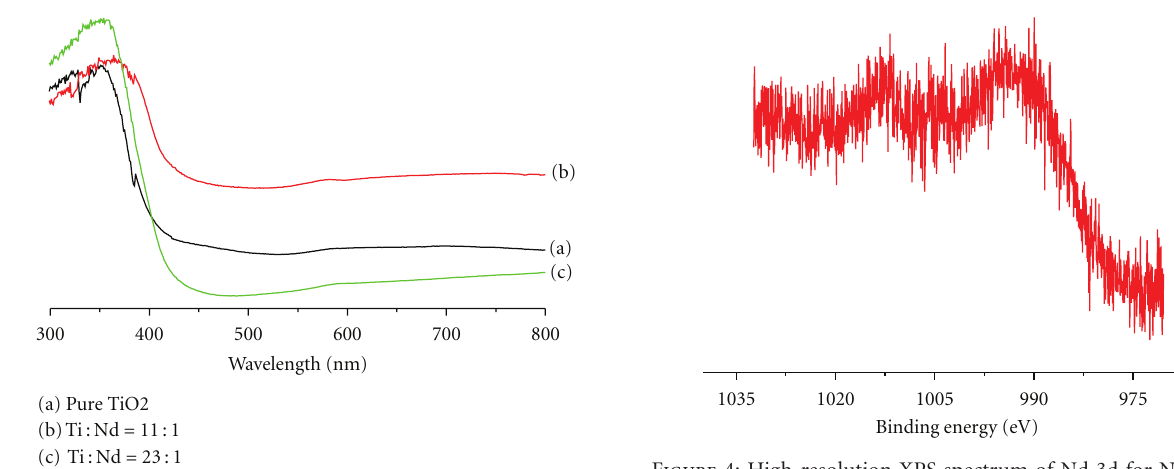
Figure 3: UV-Vis di ff use reflectance spectra of pure TiO 2 (a), Nd- doped TiO 2 with Ti:Nd = 23:1 (b), and Nd-doped TiO 2 with Ti:Nd = 11 :1 (c).